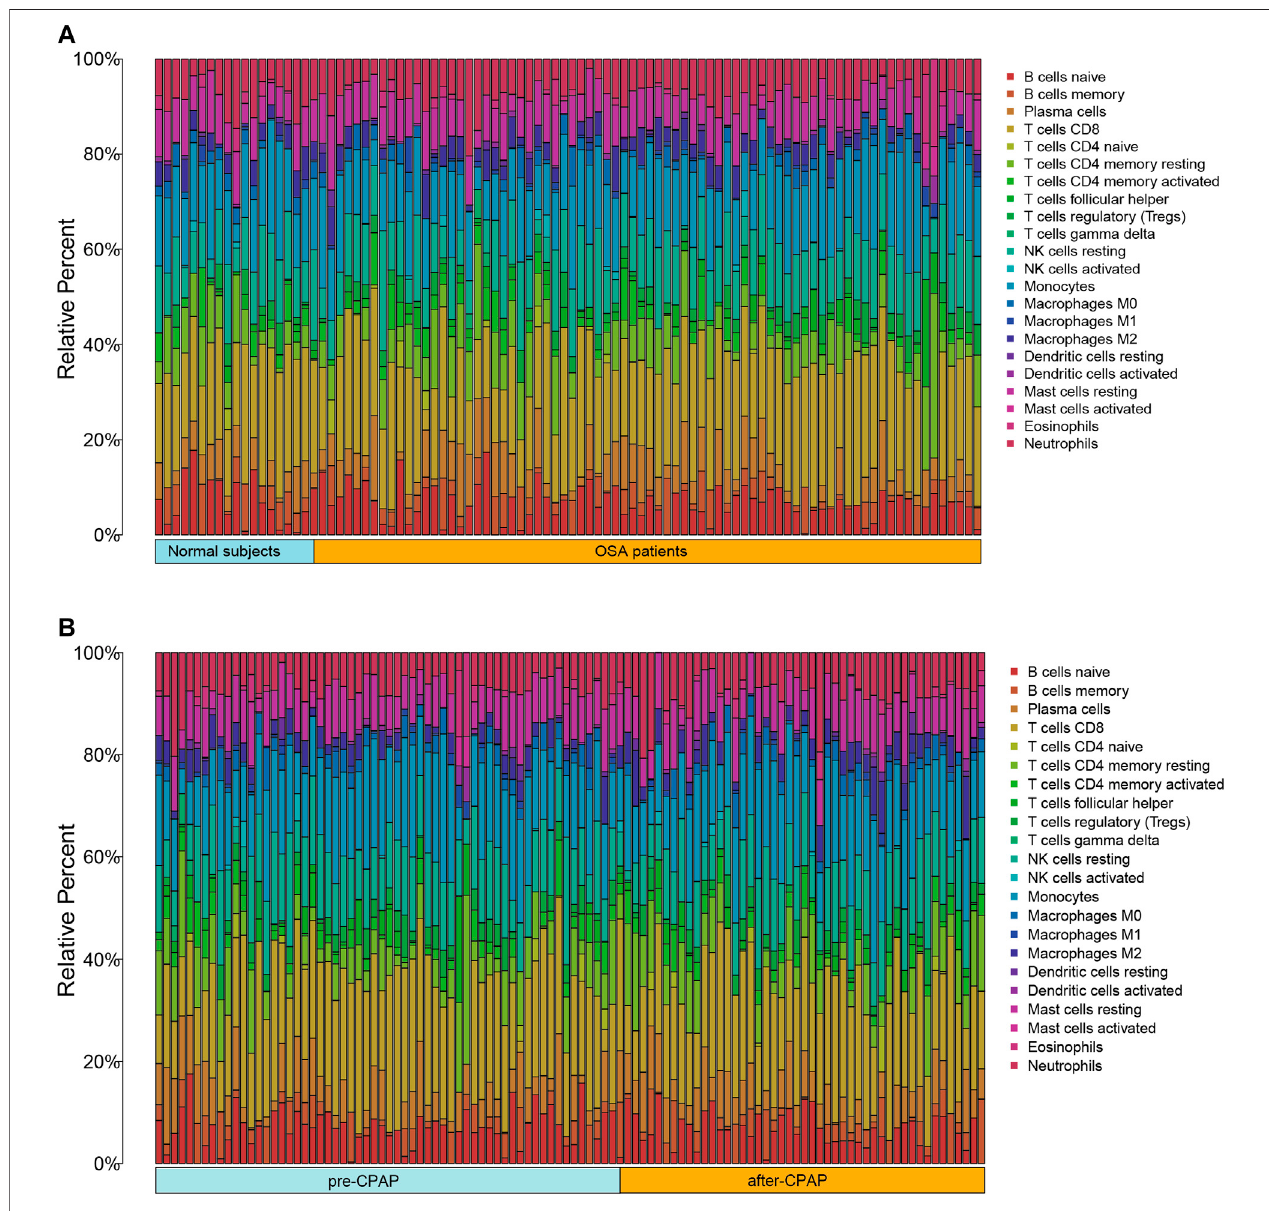
FIGURE 9 | (A) Bar chart of 22 immune in fi ltrating cells comparing OSA patients and control samples (B) Bar chart of 22 immune in fi ltrating cells comparing OSA patients before CPAP and after CPAP treatment.